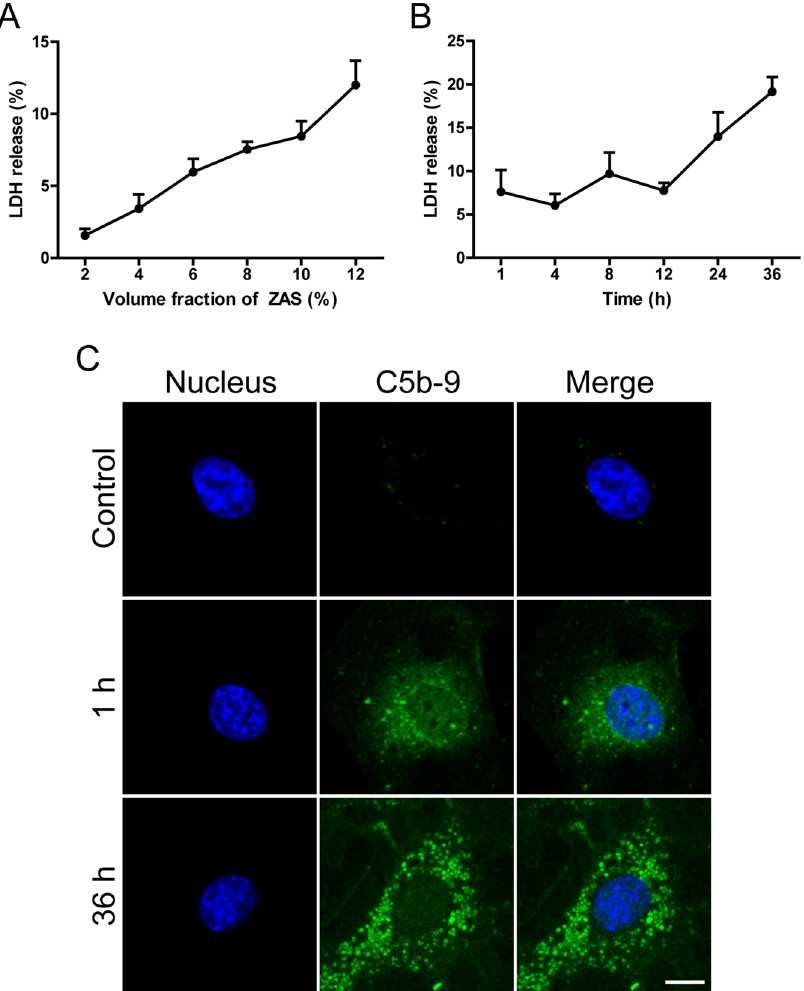
Figure 3. Assembly of sublytic C5b-9 on podocytes after exposure to zymosan activation serum (ZAS). ( A , B ) Lactate dehydrogenase (LDH) assay, quantified by the optical density of the supernatant at 450 nm. The release rate of LDH from ZAS-treated podocytes gradually increased in a volume fraction-dependent manner as of the 1-h time point. After exposure of podocytes to ZAS at 10% dilution, the release rate of LDH increased by less than 10% within 12 h, and then further increased at 24 h to 36 h. The data represent mean ± SD. ( C ) Immunofluorescent showing a lot of C5b-9-positive puncta in ZAS (10%)-treated podocytes from 1 h to 36 h, while rare in HIS (10%)-treated podocytes. The nuclei were stained with DAPI (blue). Images were obtained using a confocal microscope. Scale bar, 25 μ